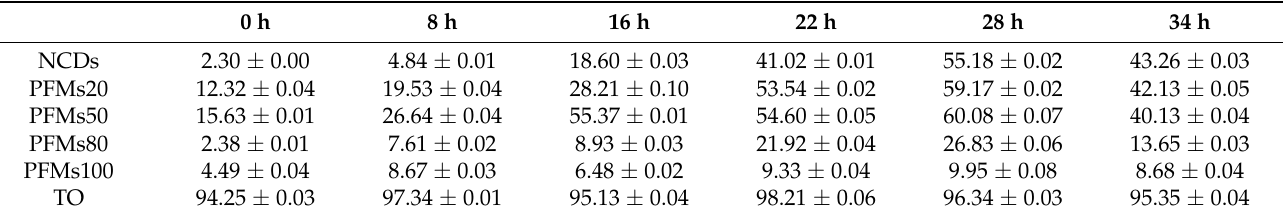
Table 1. The binding rate (%) of different size particles with different interval cultures of P. falciparum 3D7 after synchronization.